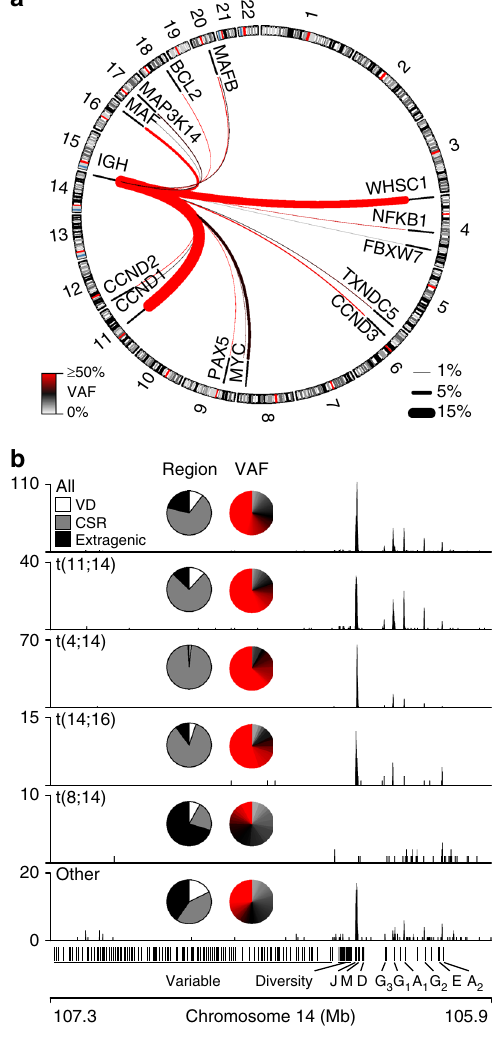
Fig. 2 IgH translocations have distinct etiologies. a Circos plot of IgH translocations in newly diagnosed myeloma patients ( N = 795). The frequency and median VAF of each type of translocation is denoted by the thickness and color of the line, respectively (key bottom left and right). b Genome (GRCh37) plots of translocations across the IgH region for all IgH translocations (top) or speci fi c types of IgH translocations (below). Inset are pie charts depicting the percentage of translocations that occur in the variable and diversity (VD), class switch recombination (CSR) ( + / − 2.5 kb), and extragenic regions (left) and the VAF of each translocation. Source data are provided as a Source Data fi